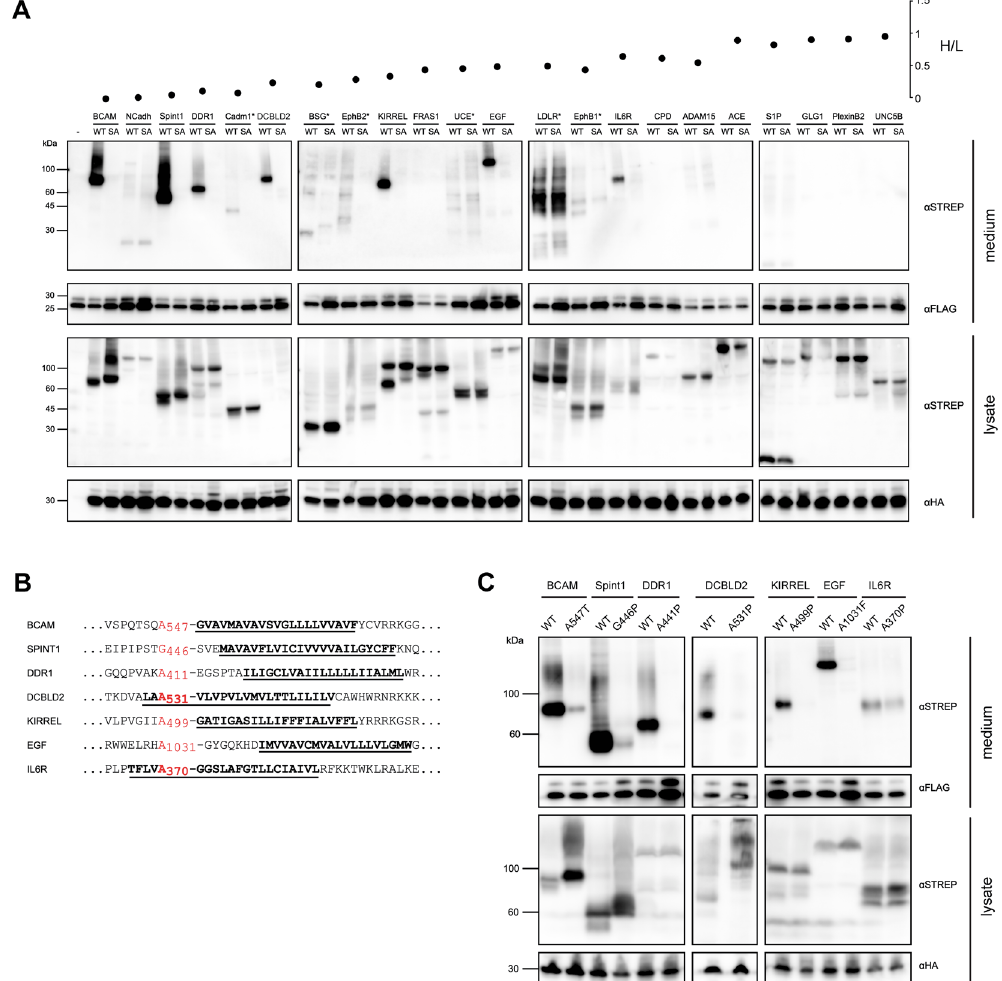
Figure 2. Validation of candidate substrates of RHBDL2 identified by SILAC proteomics screen ( A ). A selection of Strep tagged proteins identified by the SILAC screen, of increasing heavy to light ratio, were co- expressed with HA-tagged forms (lower lysate panel, α HA) of either wild-type mouse RHBDL2 (WT) or an inactive mutant in which the catalytic serine residue was mutated to an alanine (SA). Twenty four hours after transfection the media were replaced by serum free media containing a broad spectrum matrix metalloprotease inhibitor (BB94) to exclude shedding by these extracellular proteases. After 24 hours the media and cell lysates were harvested and analysed by immunoblotting for the tagged proteins using anti-Strep. Cells were co-transfected with FLAG tagged prolactin to act as a secretion control and to confirm equal recovery of TCA precipitated proteins from the media (lower media panel, α FLAG). ( B ) Summary of cleavage sites of RHBDL2 substrates identified by mass spectrometry of purified ectodomain fragments. The P1 residue is highlighted in red and the TMD is underlined and highlighted in bold. ( C ) To confirm the cleavage site, the P1 residue was mutated to a residue typically not accepted in the P1 position of rhomboid substrates, such as proline, threonine or phenylalanine 8, 17, 18 . The wild-type and mutant forms of each substrate were subsequently co-expressed with active RHBDL2 in a cellular cleavage assay as described in Fig. 1. Conditioned media (upper panels) were immunoblotted for Strep tagged substrates and FLAG tagged prolactin and cell lysates (lower panels) immunoblotted for Strep tagged substrates and HA tagged RHBDL2